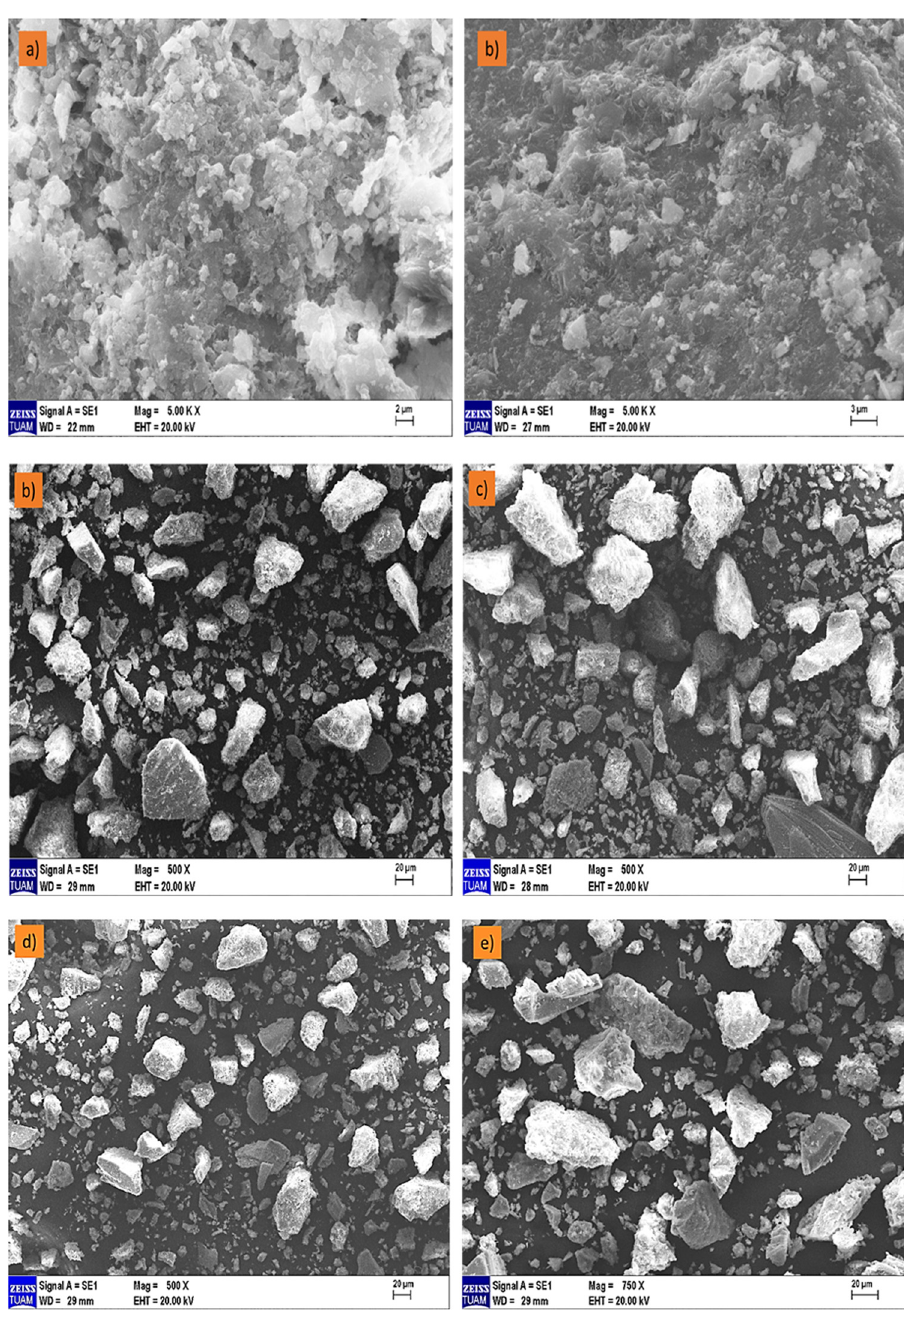
Figure 5: SEM images of grinded materials according to crusher types; raw GVT ( a ) ; raw BVT ( b ) ( under 2 cm ) ; GVT roller ( c ) ; BVT roller ( d ) ; GVT hammer ( e ) ; and BVT hammer ( f )